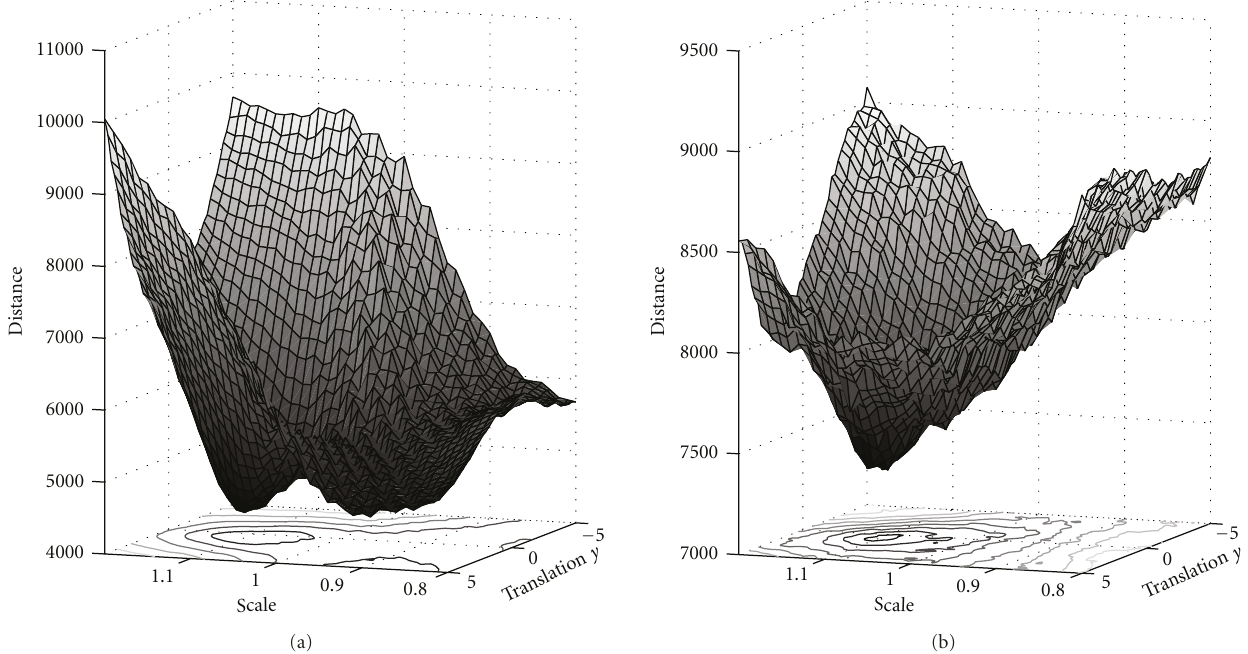
Figure 2: A 2D search space based on the grey level image (a) and edge image (b), for scale (a-b) and translation in y direction (front-back), showing a local minimum in the left score